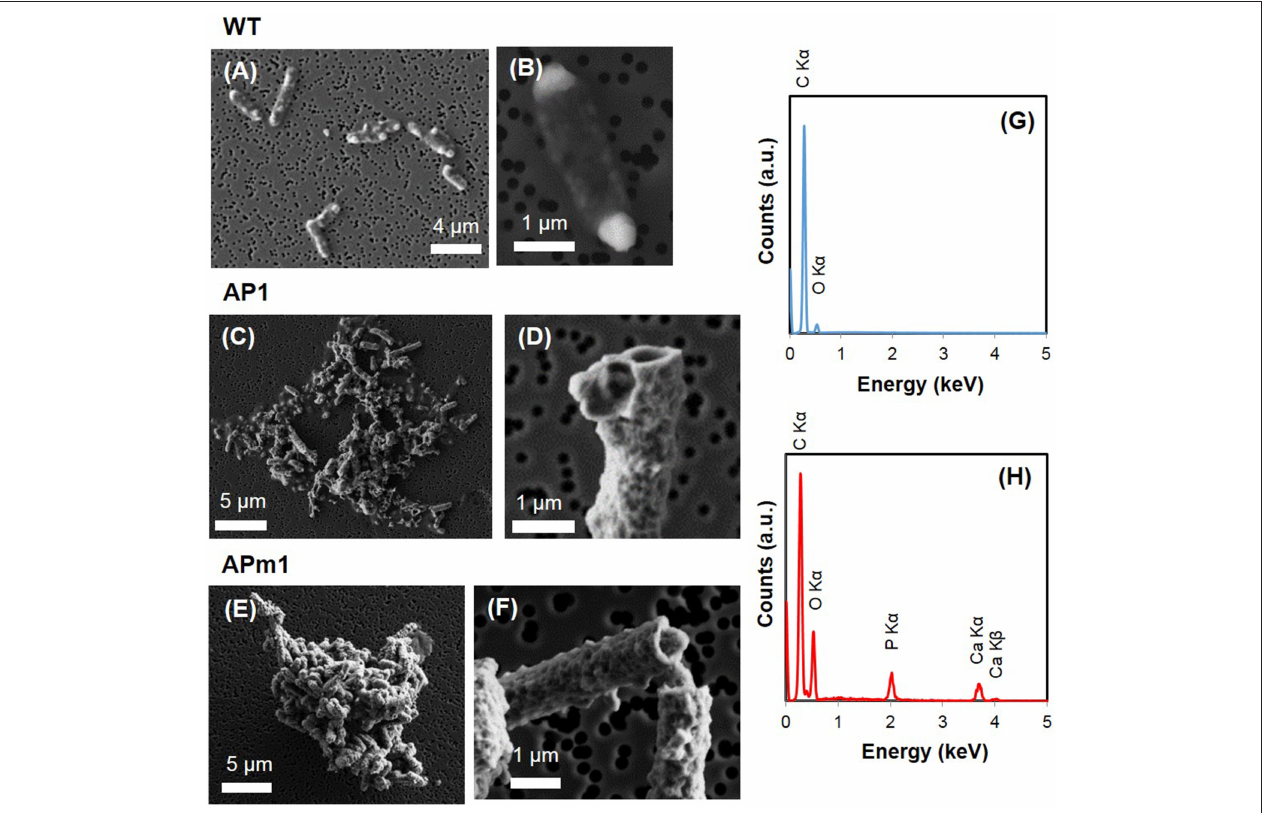
FIGURE 2 | SEM images of WT, AP1, and APm1 E. coli after 24 in the calcification medium. (A,B) WT E. coli . (C,D) AP1. (E,F) APm1. (G) EDXS spectrum obtained on WT E. coli cells. (H) EDXS spectra obtained on calcified APm1 cells.